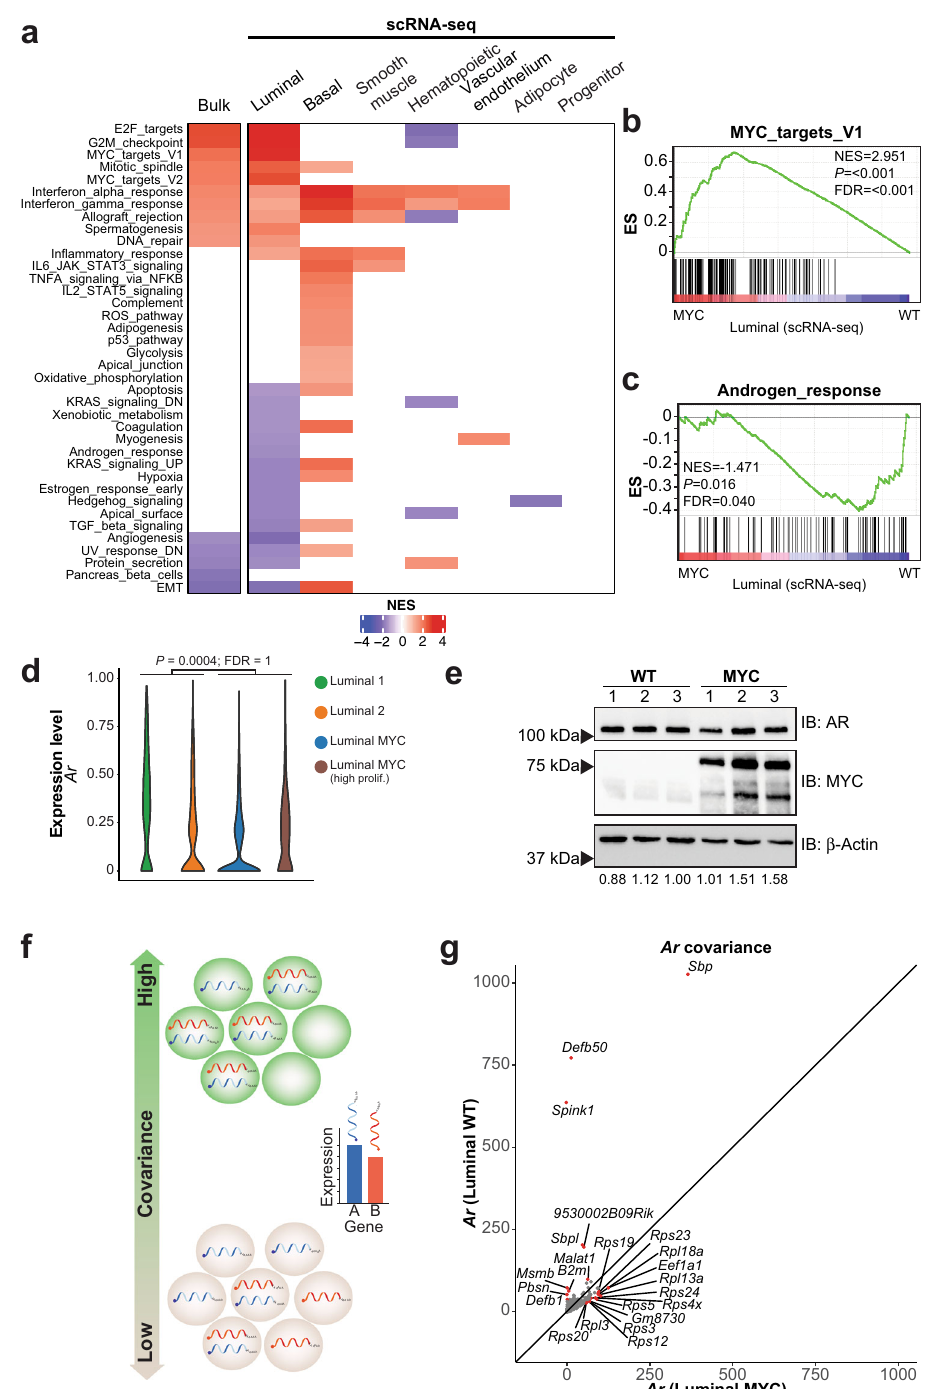
Fig. 3 MYC-driven luminal cells transformation dampens the AR transcriptional program. a Gene Set Enrichment Analysis (GSEA, Hallmark, P < 0.05 and FDR < 0.1) revealed that the bulk RNA-seq transcriptional program associated with MYC overexpression is mostly driven by the luminal subset (VP; matched bulk and single-cell RNA-seq; n = 1 per genotype; Source data are provided as a Source Data fi le). b , c MYC overexpression is associated with an enriched MYC transcriptional program ( b P < 0.001 and FDR < 0.001) and a depleted AR response ( c P < 0.016 and FDR < 0.040) in the luminal subset (GSEA; VP; n = 1 per genotype). d , e MYC overexpression does not alter AR transcript expression in the luminal compartment ( d VP; n = 1 per genotype; edgeR: two-sided quasi-likelihood F-test) and protein levels in the VP ( e VP; n = 3 per genotype; numbers at the bottom represent AR levels relative to β -Actin; Source data are provided as a Source Data fi le). f Schematic representation of covariance analysis to determine co-expression (i.e. positive covariance) or mutually exclusive expression (i.e. negative covariance) between two genes at a single cell level. g Covariance analysis in the luminal subset reveals a shift from canonical AR target genes in the transcripts co-expressed with Ar upon MYC overexpression (VP; n = 1 per genotype). NES: normalized enrichment score; ES: enrichme n t